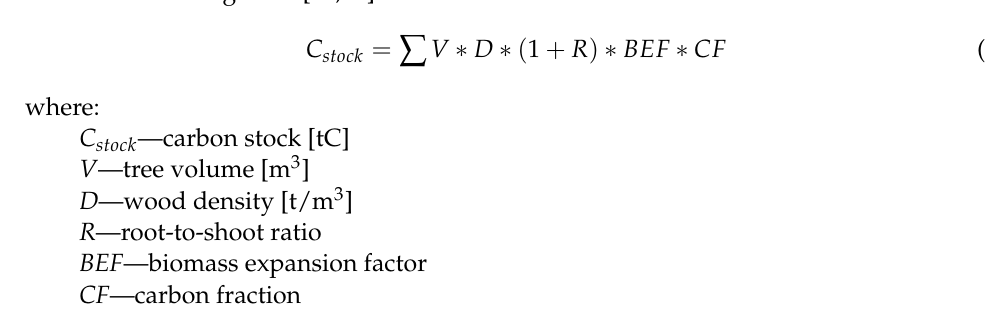
Table 4. Carbon stock required